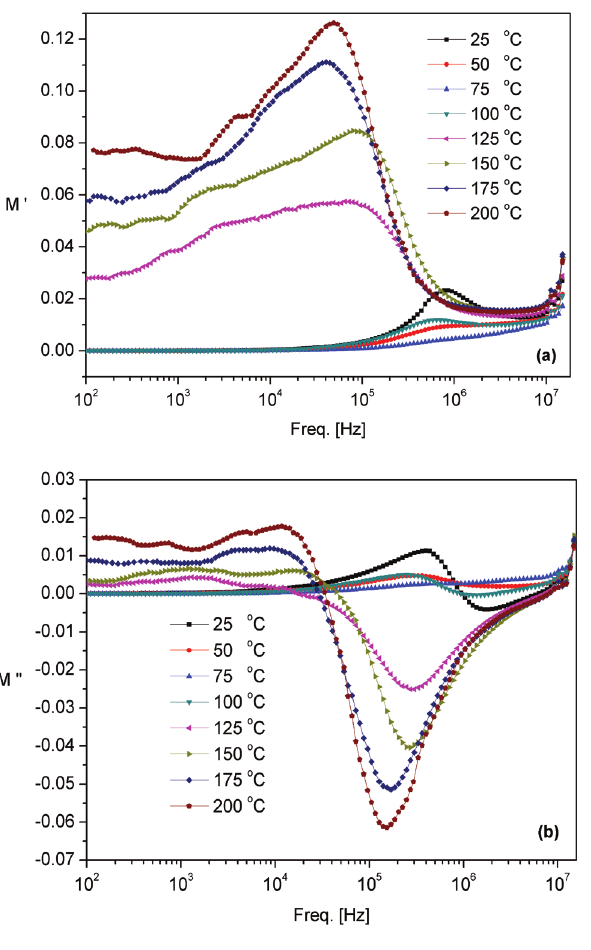
Fig. 2: Frequency dependency of the electrical modulus at various temperatures; a) real part of the ECTW, b) imaginary part of the ECTW.